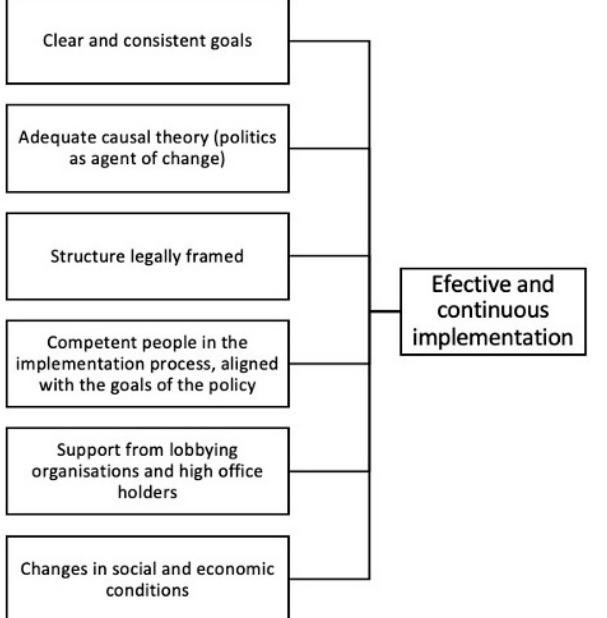
Figure 4. List of conditions for effective implementation of policies. Source: elaborated by the authors, based on Sabatier and Mazmanian, 1980 [35].